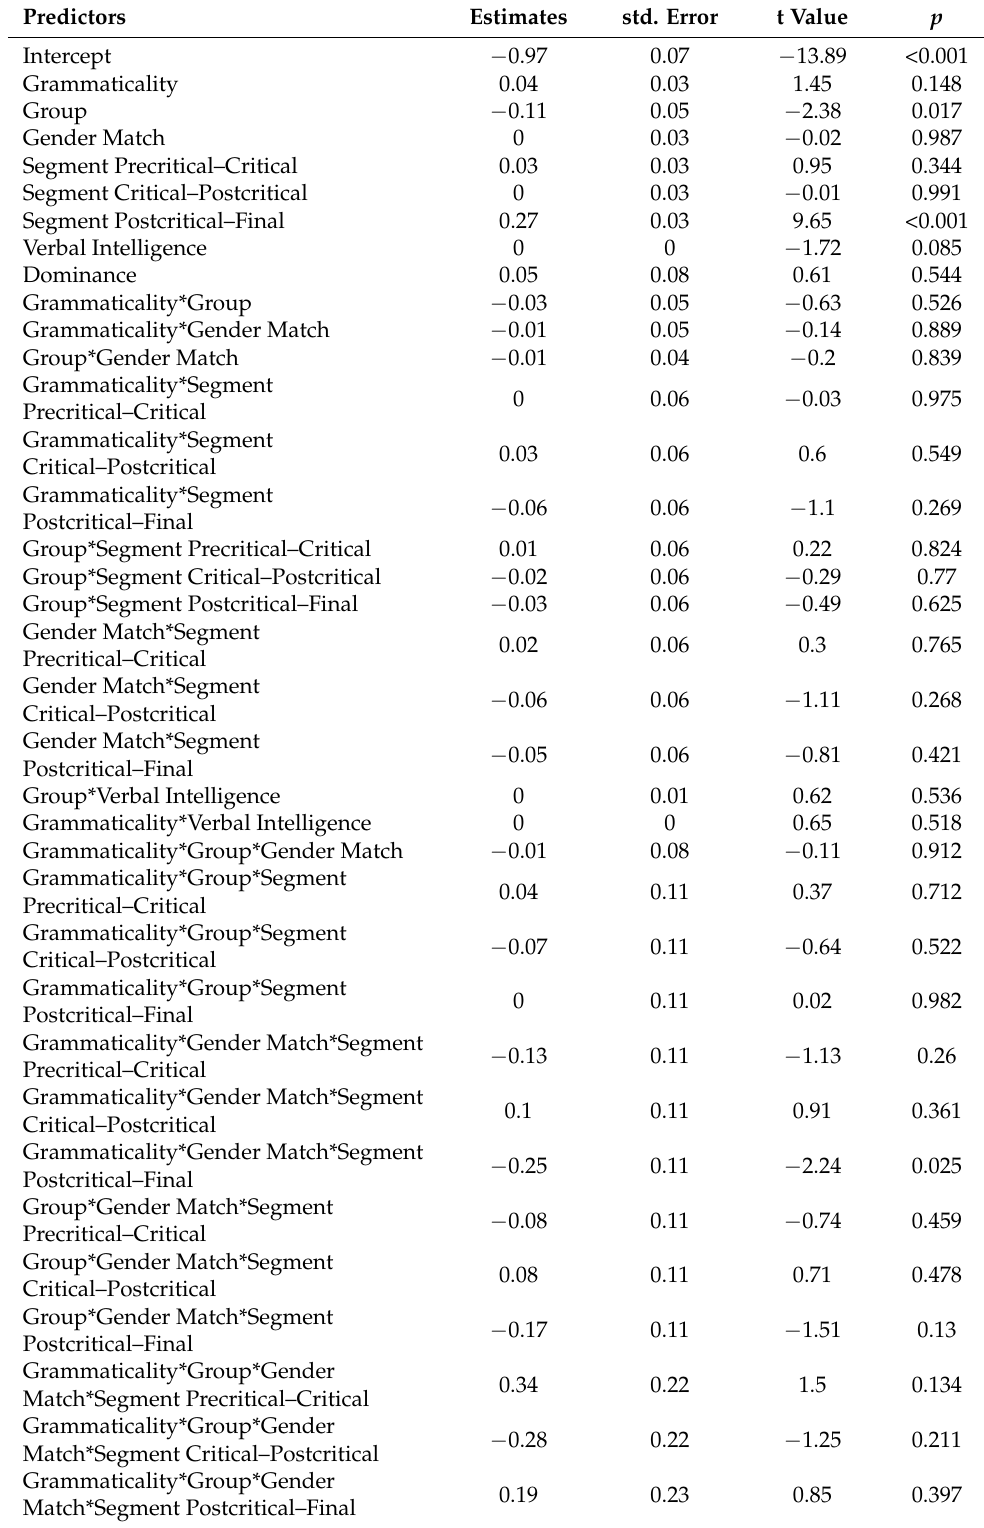
Table A13. Summary of the model with the whole dataset and verbal intelligence and dominance as